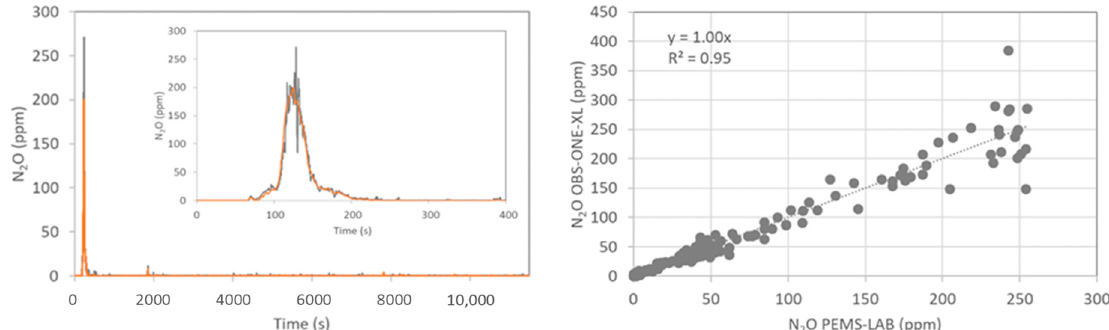
Figure 6. ( Left panel ) N 2 O emission profiles measured on-road using the OBS-ONE-XL (grey) and the PEMS-LAB (orange) over the real-driving conditions. The left panel also shows a close-up on the first 400 s. ( Right panel ) Correlation of the N 2 O concentrations measured by the OBS-ONE-XL plotted against that measured by the PEMS-LAB.